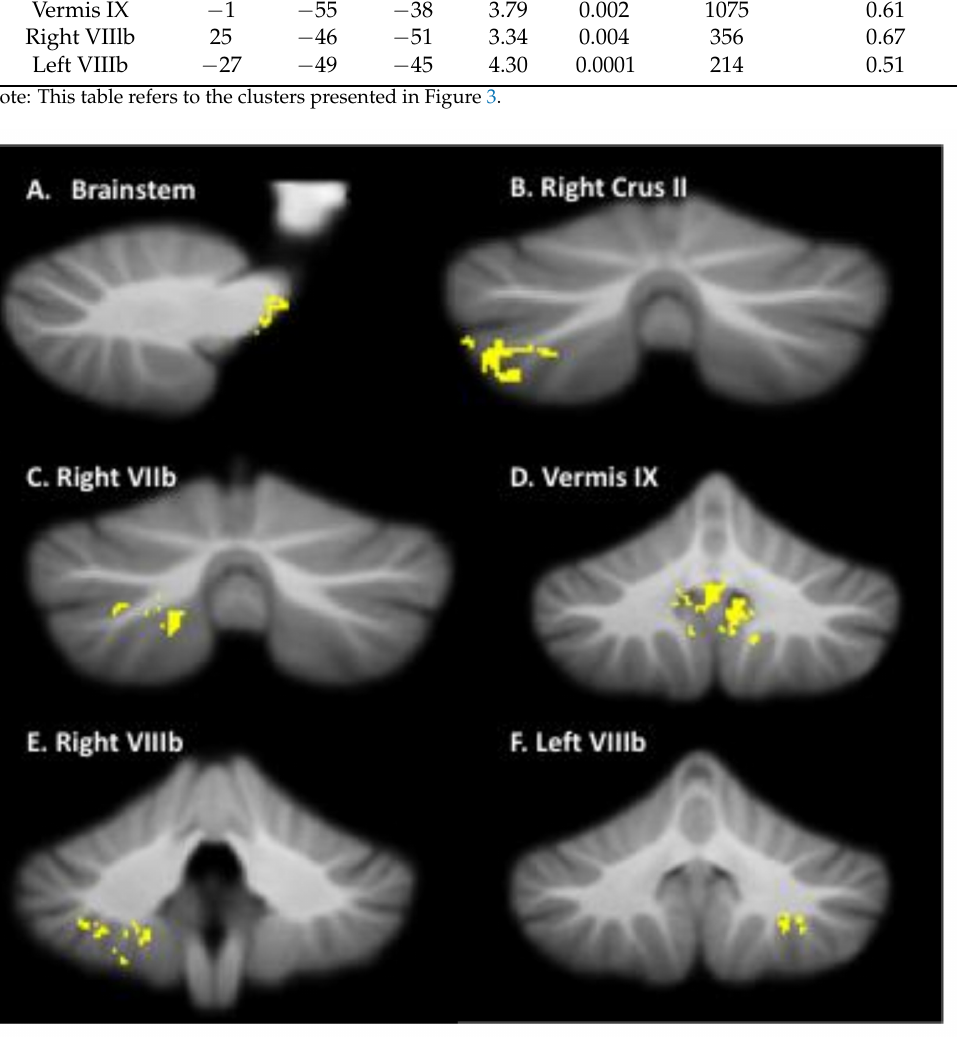
Figure 3. Regression analysis of Performance Quality Rating Scale (PQRS) and regional gray matter changes. This figure shows that higher PQRS scores predict increased gray matter volume in the brainstem, right crus II, right VIIb, vermis IX, and right and left VIIIb lobules. Note: This figure corresponds to Table